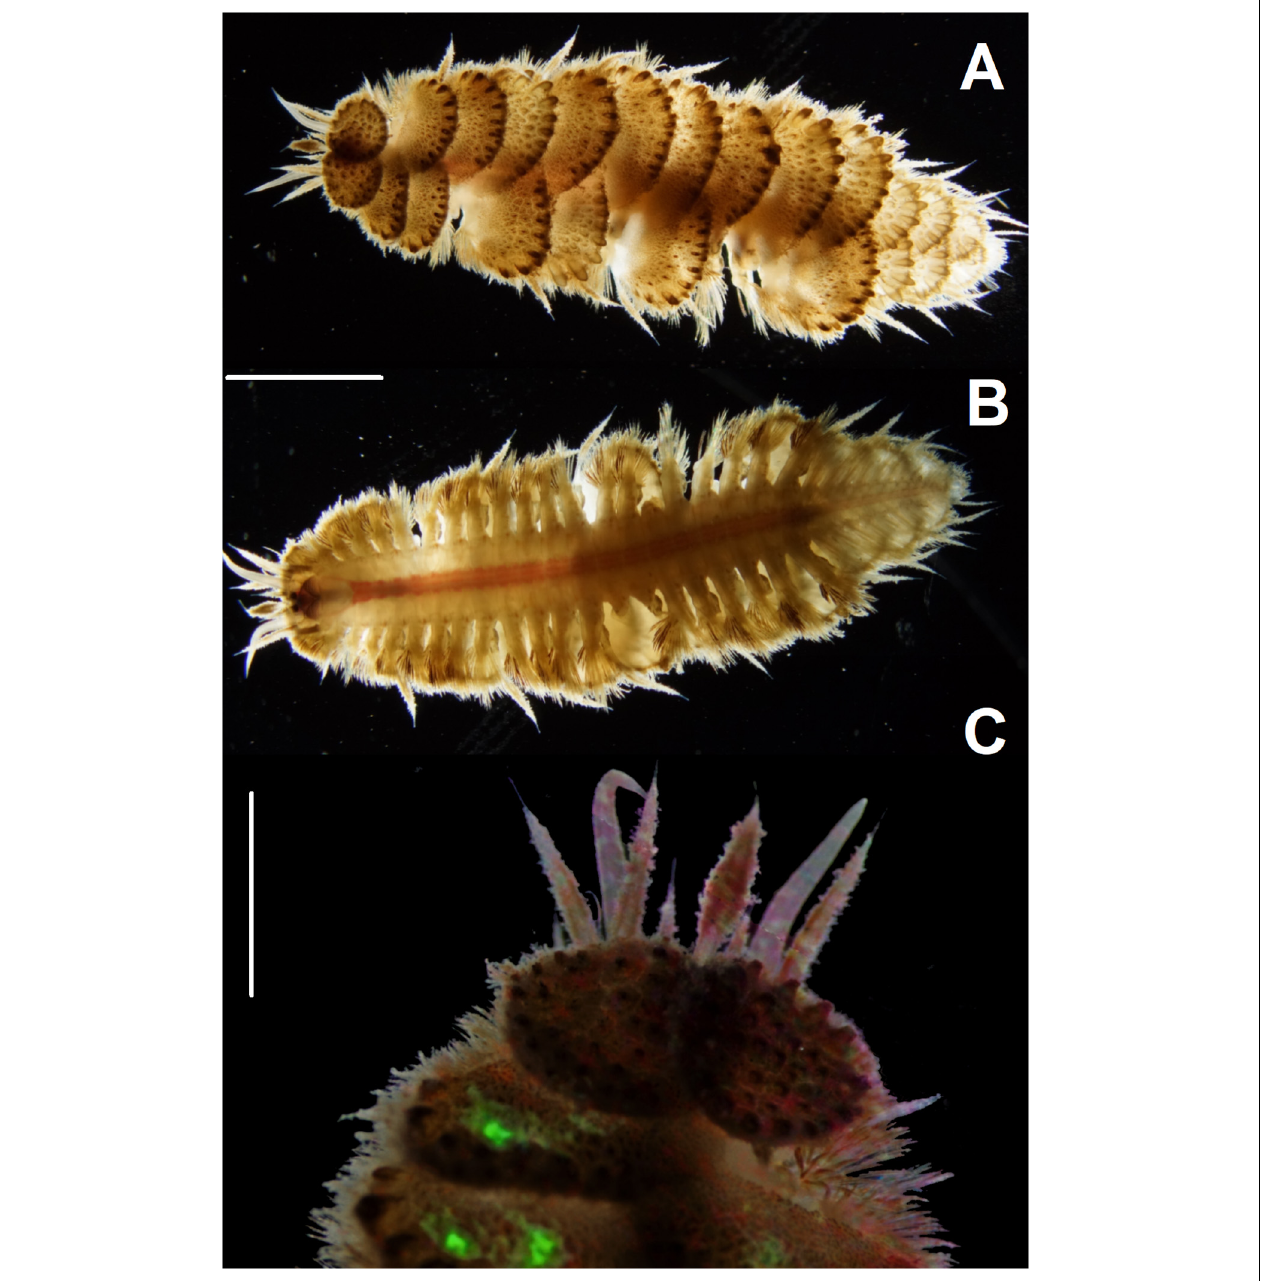
FIGURE 2 | Images of Harmothoe sp. collected in the South Atlantic (Brazilian coastline, southern region) photographed with a stereomicroscope Zeiss SV-11 coupled with a Sony a7s digital camera. (A) dorsum with elytra, (B) ventral view and (C) anterior region displaying green bioluminescence by mechanical stimulation. Scale bars: (A,B) = 0.5 cm and (C) = 0.25 cm. Photos: Álvaro Migotto, Anderson G. Oliveira, and Gabriela V. Moraes. Images were processed using Adobe Photoshop CC.